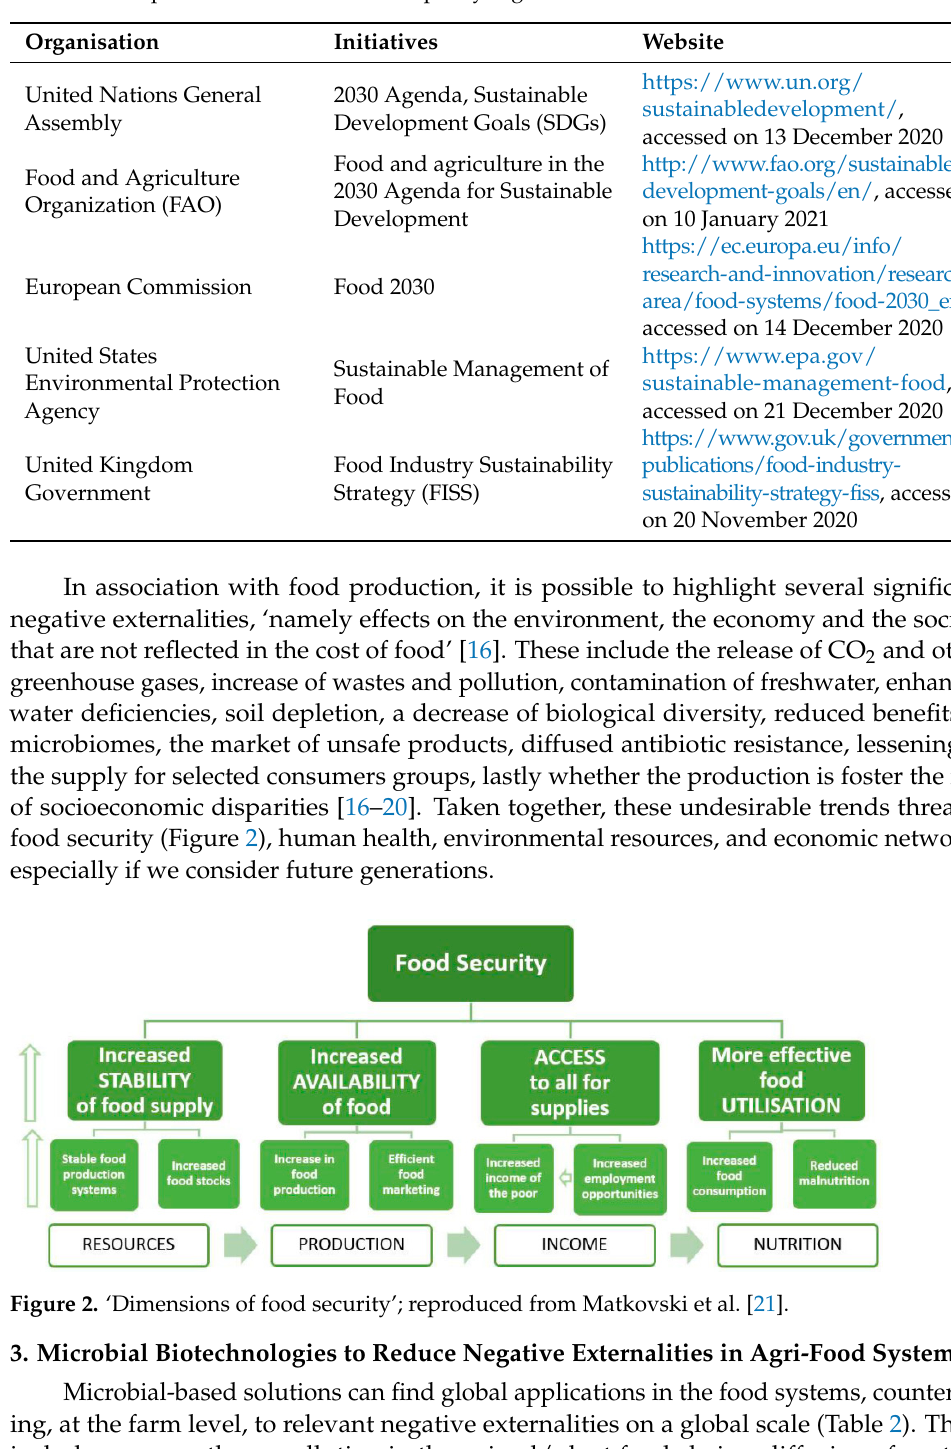
Table 1. Example of tailored initiatives of policy organisations.